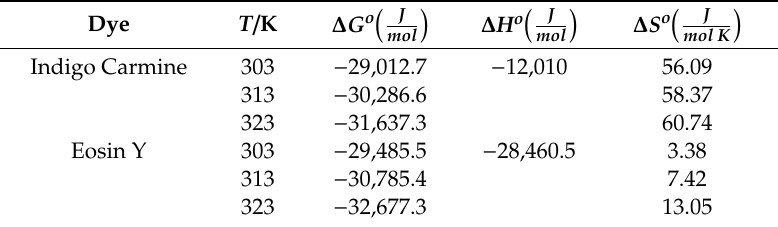
Table 4. Summary of the thermodynamic